Question: Describe this figure in one sentence.
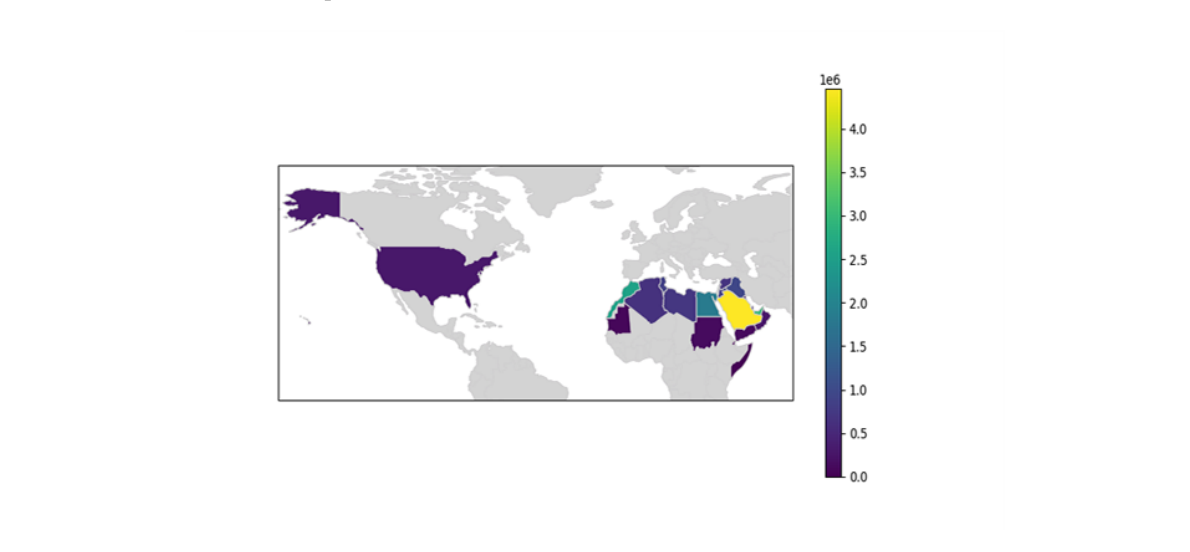
Answer: Geographical Distribution of Arabic Websites Categorized by Country Domain Names